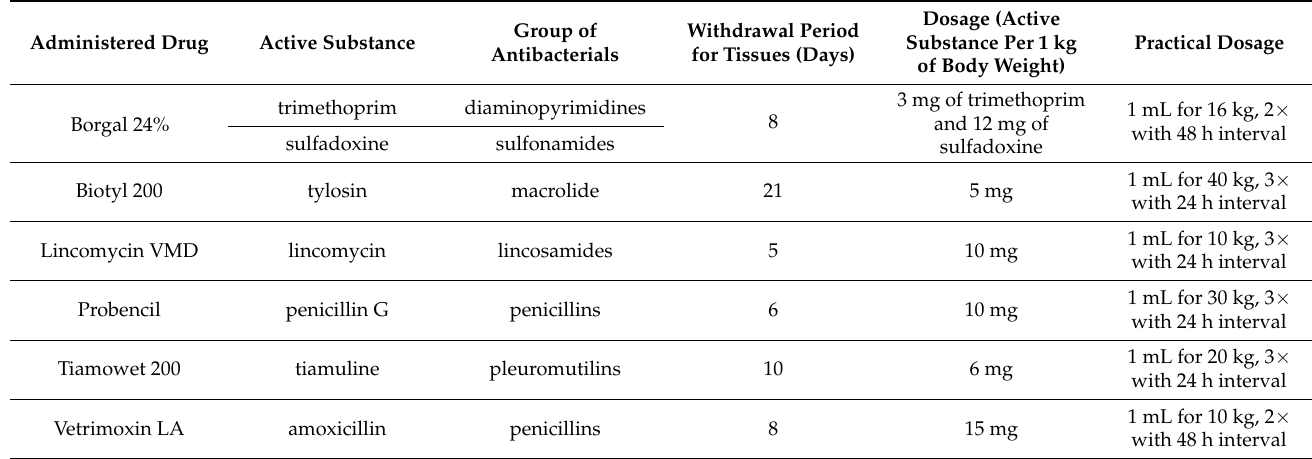
Table 3. Drugs and dosage administered to